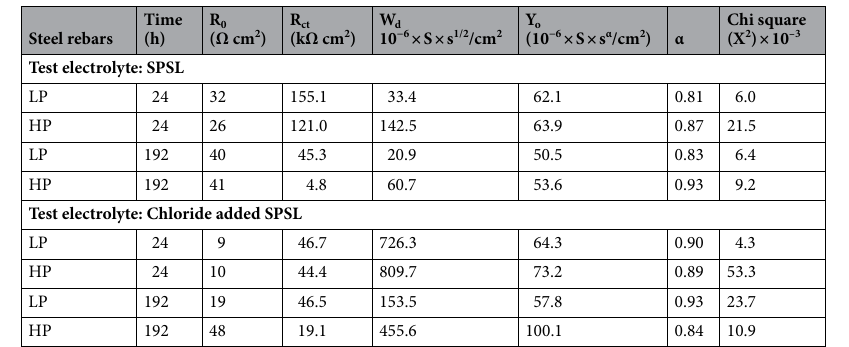
Table 2. Quantitative data extracted from the EIS plots shown in Figs. 10, 11, 12 and 13 using the CPE model of the equivalent circuit presented in Fig. 18.